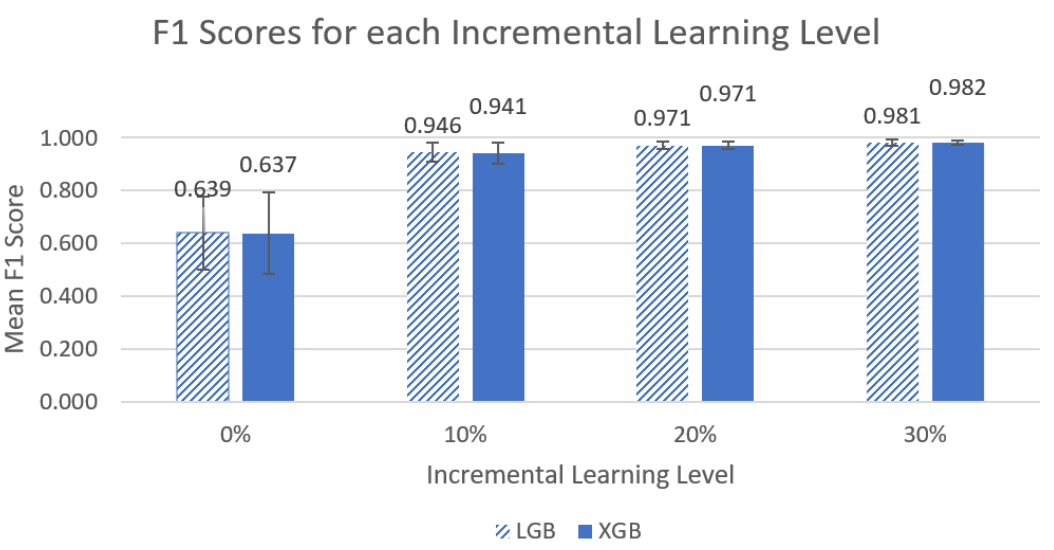
Figure 6. Graph of left ‐ side lying, supine, or right ‐ side lying classification mean F1 metrics for the LGB and XGB models across the four different incremental learning levels. The error bars represent standard deviation.